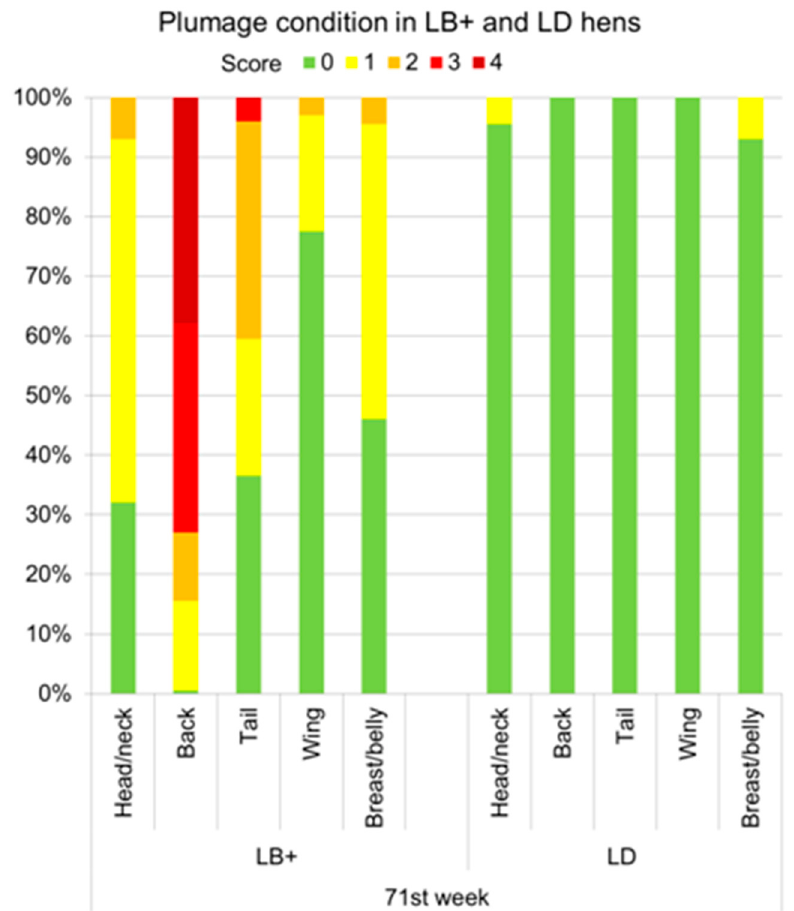
Figure 2. Proportions of LB+ and LD hens ( n = 400) with different plumage scores (0 (best) to 4 (worst)) for head/neck, back, tail, wing, and breast/belly obtained by the VSc method in the 71st week of life. Integument damage in the form of single injuries <0.5 cm diameter or length (score 1) occurred